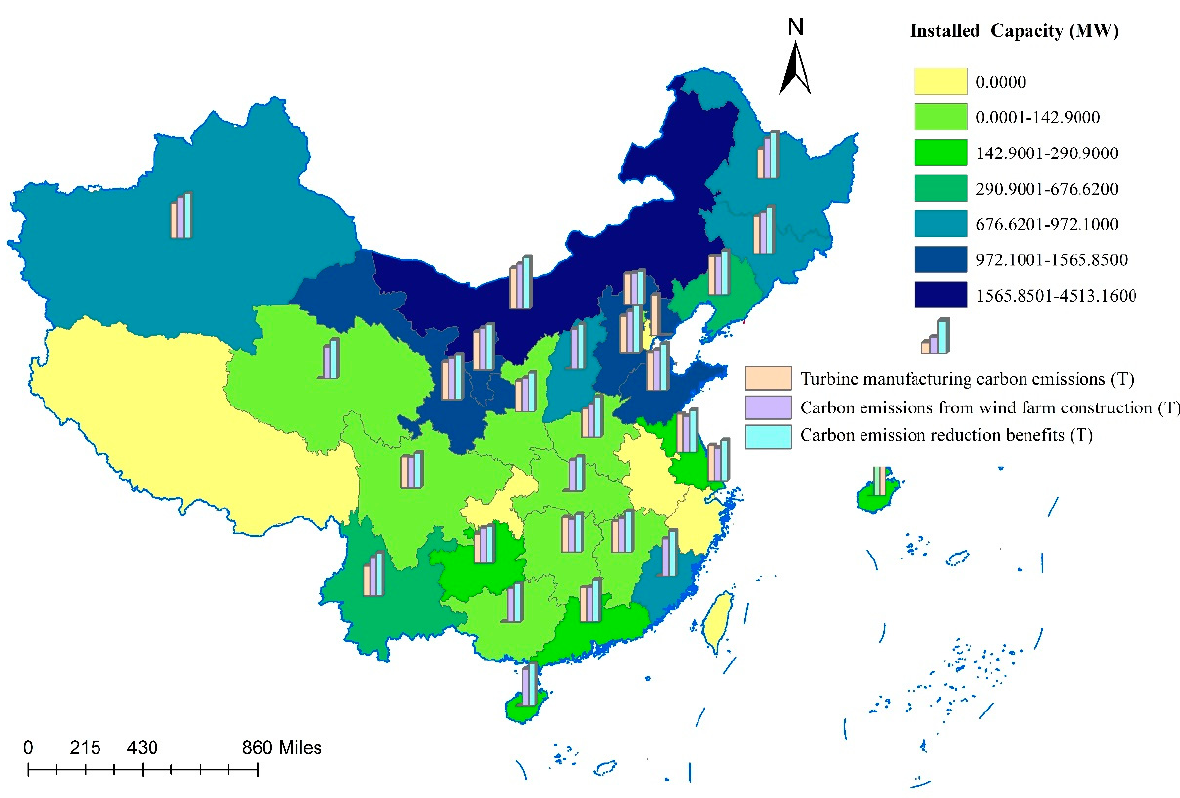
Figure 8. Distribution of carbon emissions and emission reduction benefits in different provinces (Note: Figure 8 shows the logarithm of real value)